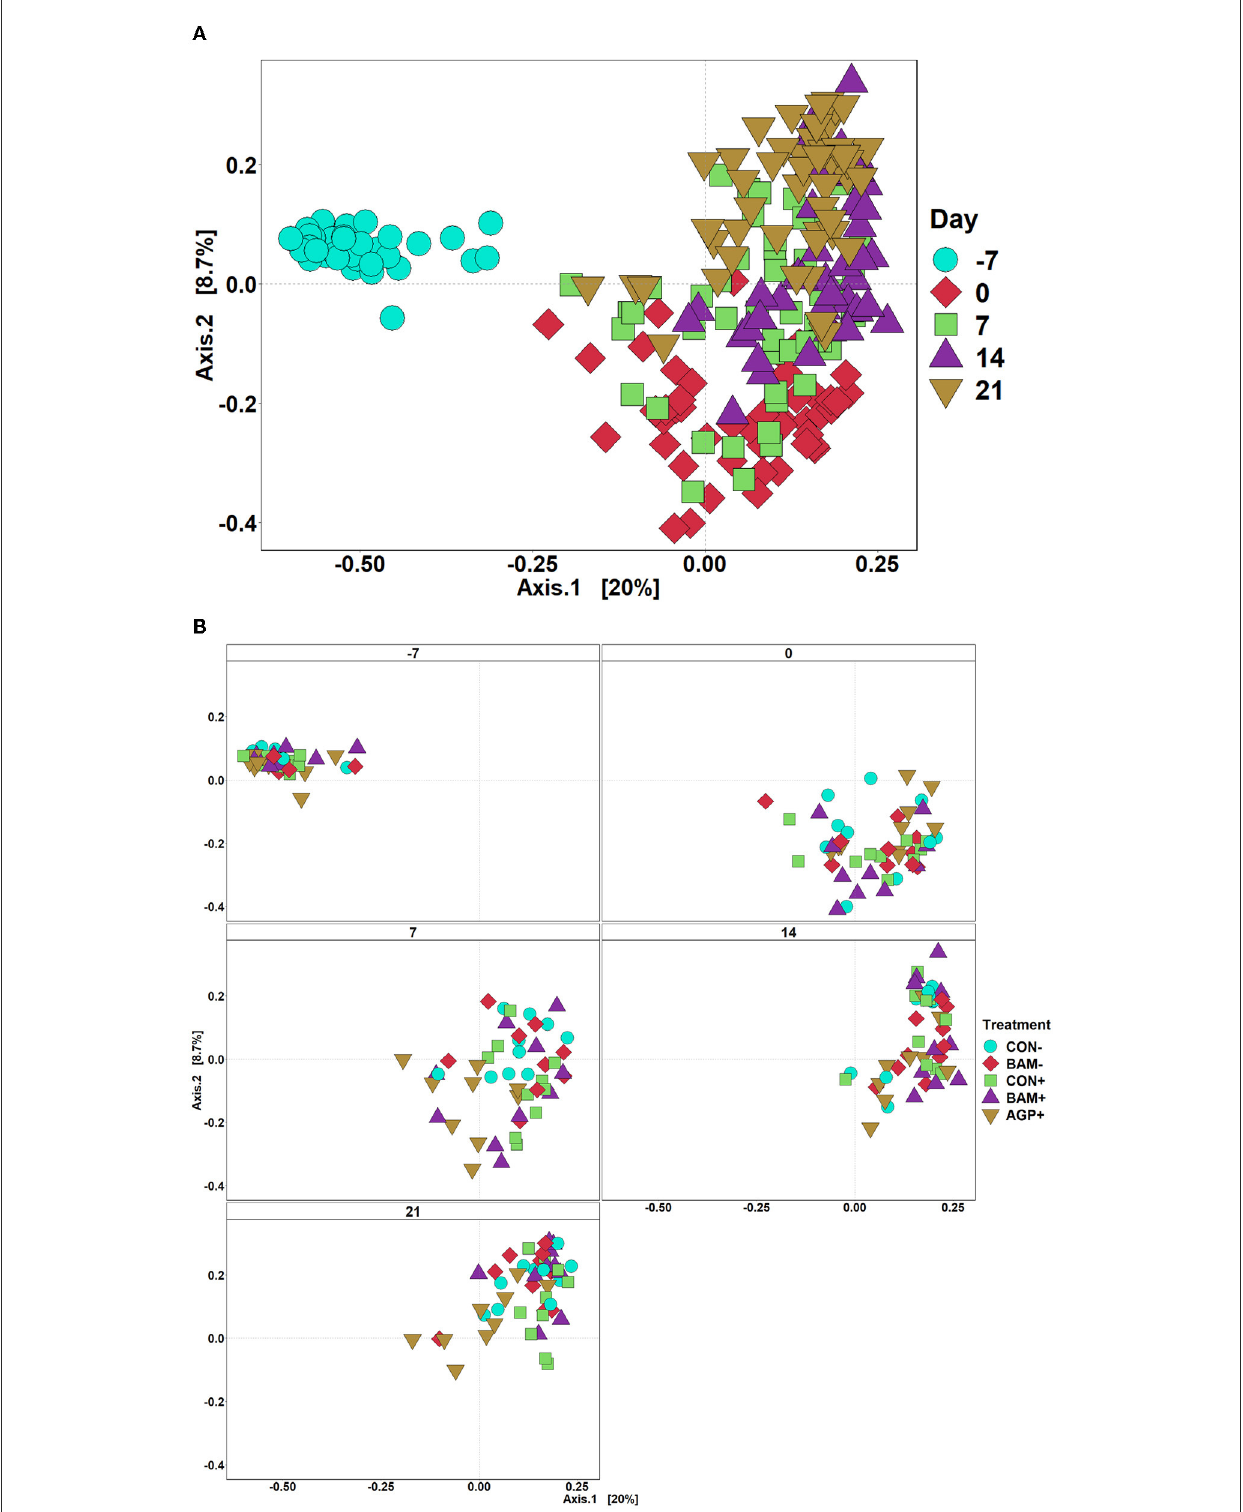
FIGURE5 Principal coordinate analysis (PCoA) based on Bray-Curtis distance for beta diversity of fecal samples of weaned pigs fed with a control (CON) diet or diets supplemented with Bacillus amyloliquefaciens (BAM) or antibiotics (AGP). Different symbols and shapes represent day fecal samples collected on days − 7 and 0 before E. coli (ETEC) inoculation and days 7, 14, and 21 post-inoculation (A) . Different symbols and shapes represent treatments (B) . Each treatment has 9–10